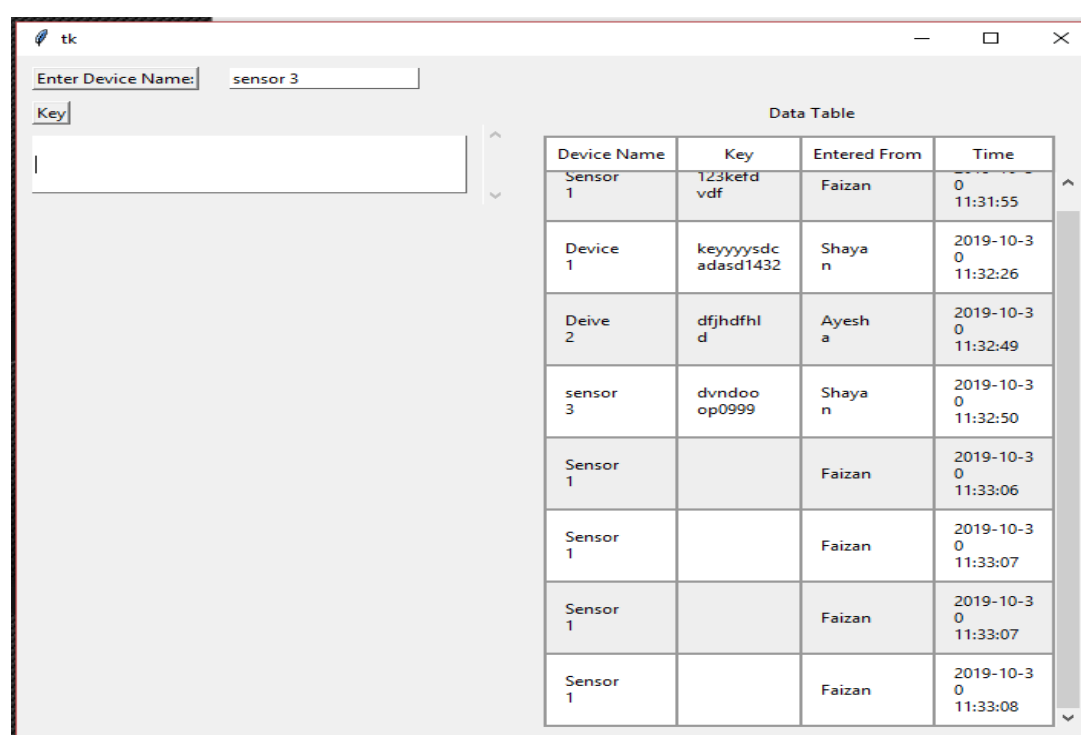
Figure 6. New node joined.